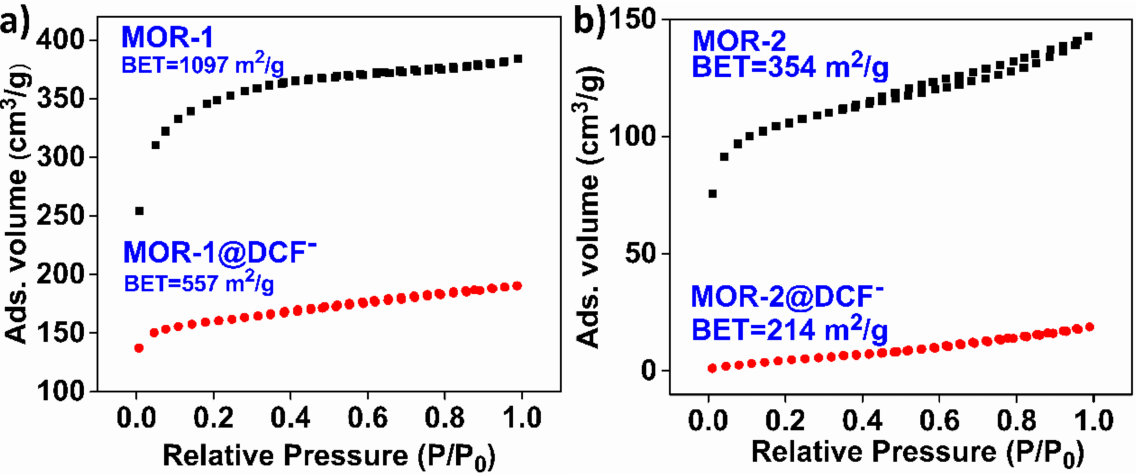
Figure 10. N 2 adsorption isotherms (77 K) for ( a ) MOR-1 , MOR-1@DCF − , and ( b ) MOR-2 , MOR- 2@DCF −